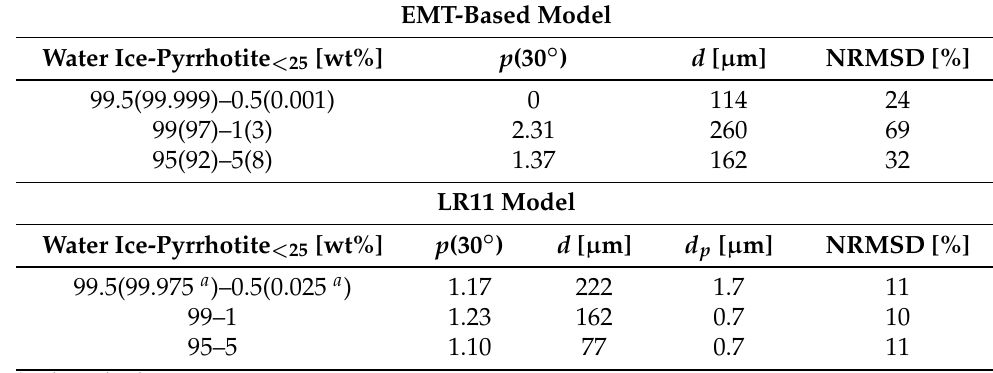
Figure 13. Measured (solid lines) water ice–pyrrhotite intraparticle mixture spectra compared to fits (dashed lines) with the EMT-based model ( a , b ) and the LR11 model ( c , d ). Water ice (I) and pyrrhotite (P) nominal mass fractions are indicated. The light grey bands indicate a spectral region where possible residual water vapour contamination in the optical path may affect the resulting spectra. Table 2. Water ice–pyrrhotite < 25 intraparticle mixture modelling parameters for the EMT-based model (top panel) and the LR11 model (bottom panel). For the EMT-based model, the nominal mass fractions are compared with the fit-estimated values (in parenthesis). For the LR11 model, the nominal mass fractions are assumed in the fitting routine, if not specified (in parentheses). The resulting value of the single particle phase function p ( 30 ◦ ) is indicated, along with the estimated size of the icy grains d and the NRMSD. For the LR11 model, the estimated size of the pyrrhotite inclusions d p is also